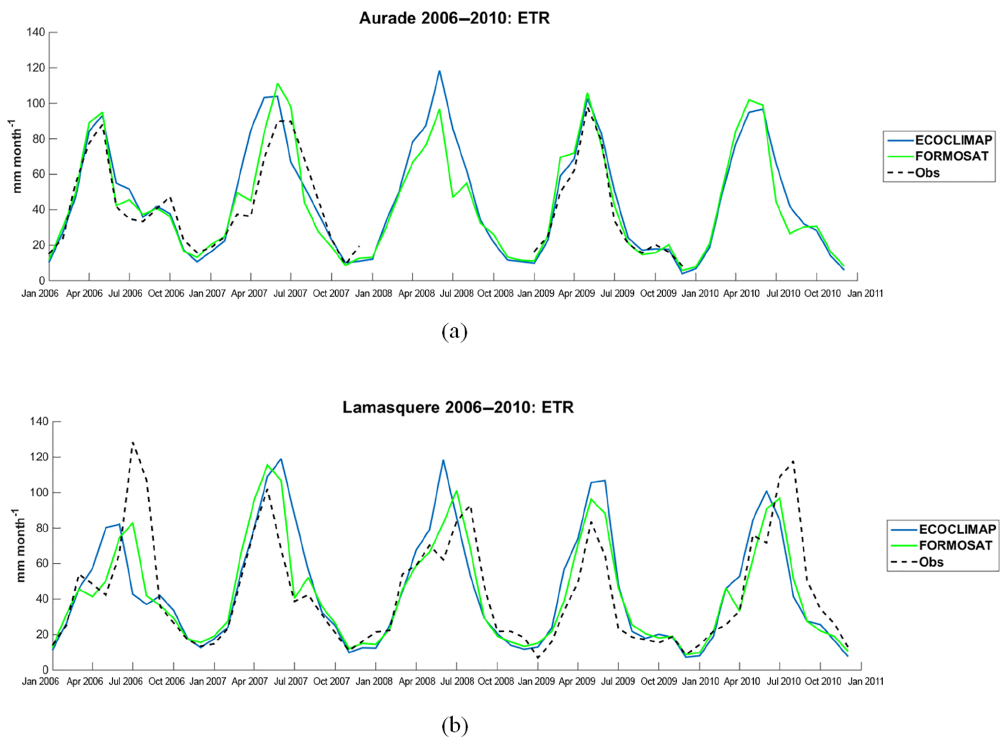
Figure 6. Evapotranspiration time series for Auradé (a) and Lamasquère (b) for 2006 to 2010. The crop type for each year is described in Tables 2 and 3. Table 4. Differences between FORMOSAT and ECOCLIMAP experiments on the annual drainage level in mmyr − 1 and the corresponding fraction of annual precipitation in percent